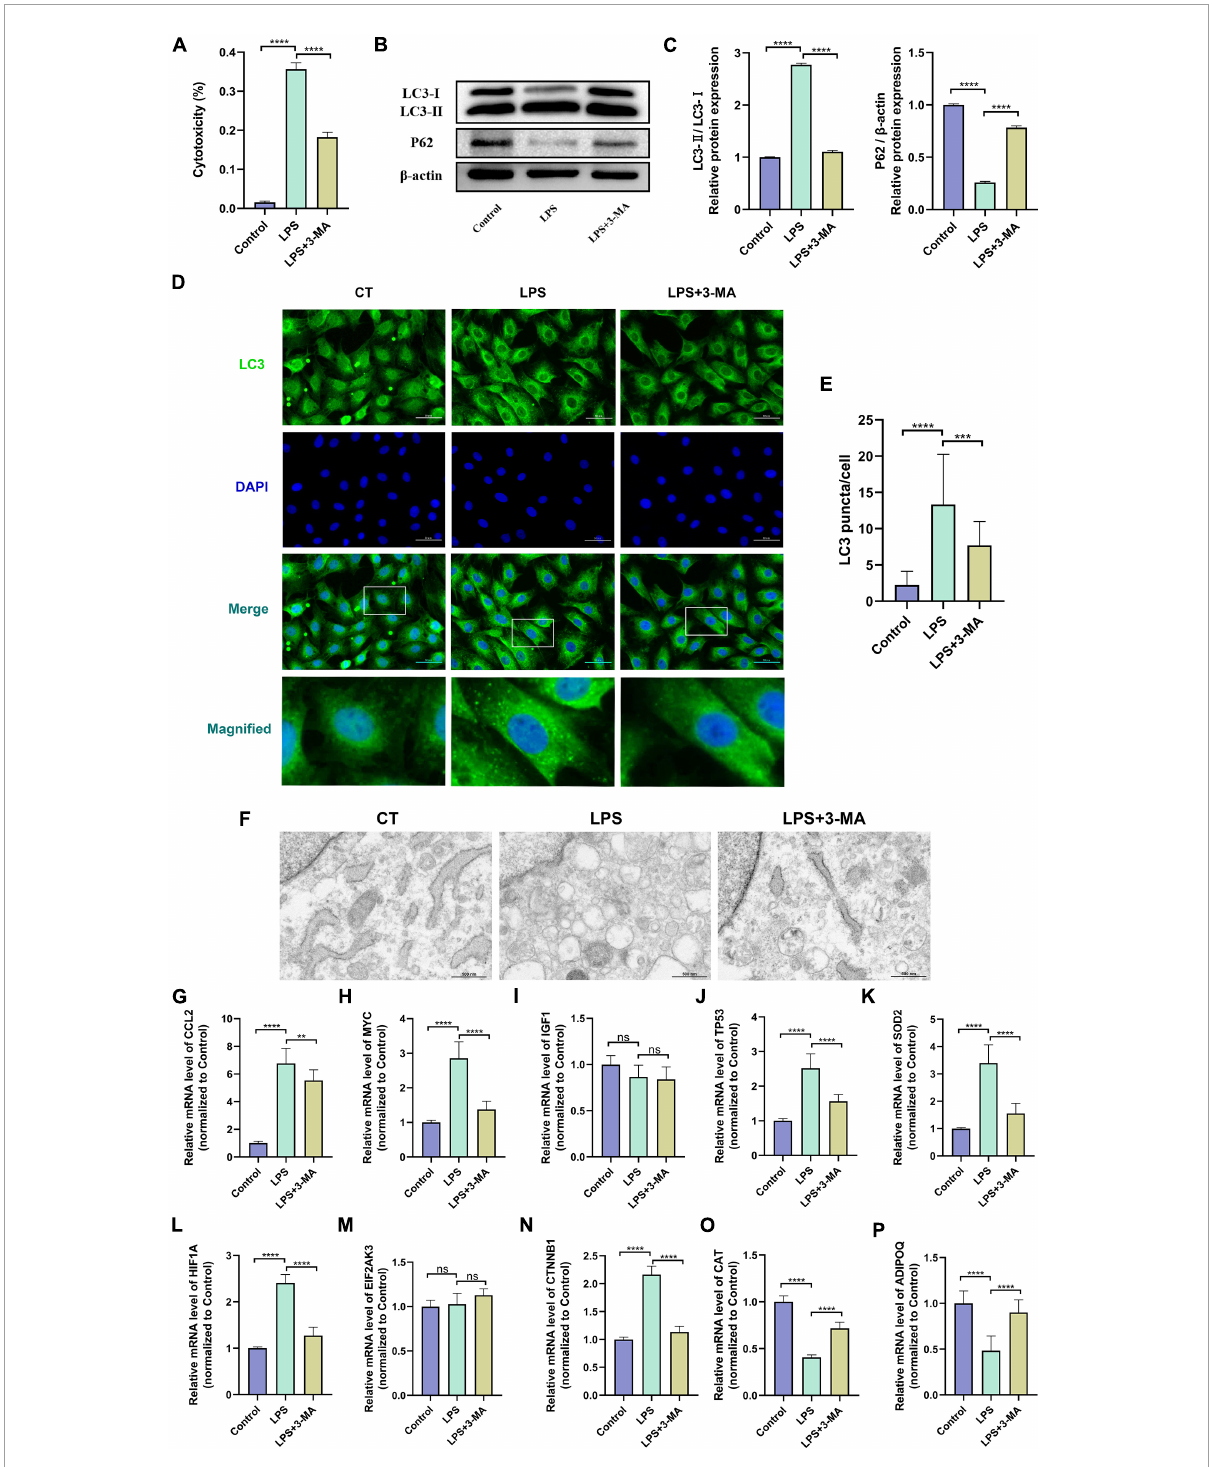
FIGURE6 (A) Altered autophagy level and validation of hub gene expression in LPS-induced H9c2 myofibroblast injury model. H9c2 myofibroblasts were treated with LPS (10 µ g/ml) for 24 h in the presence or absence of 3-MA (5 µ M) pretreatment, followed by subsequent experiments. (A) Cytotoxicity determined by the release of lactate dehydrogenase. (B) Representative western blotting bands of LC3 and P62. (C) The LC3-II/I ratio and the relative protein levels of P62 estimated by ImageJ software. (D) Representative images of LC3B immunofluorescence in H9c2 myofibroblasts. (E) The Ratio of the number of LC3 puncta to the number of cells in each group. (F) Representative images of transmission electron microscopy in H9c2 myofibroblasts. (G–P) mRNA expression levels of hub genes detected by qRT-PCR. LPS, lipopolysaccharide; 3-MA, 3-methyladenine. ∗∗ p < 0.01, ∗∗∗ p < 0.001, ∗∗∗∗ p < 0.0001, ns = not significant. Data are presented as the mean ± SD, n ≥